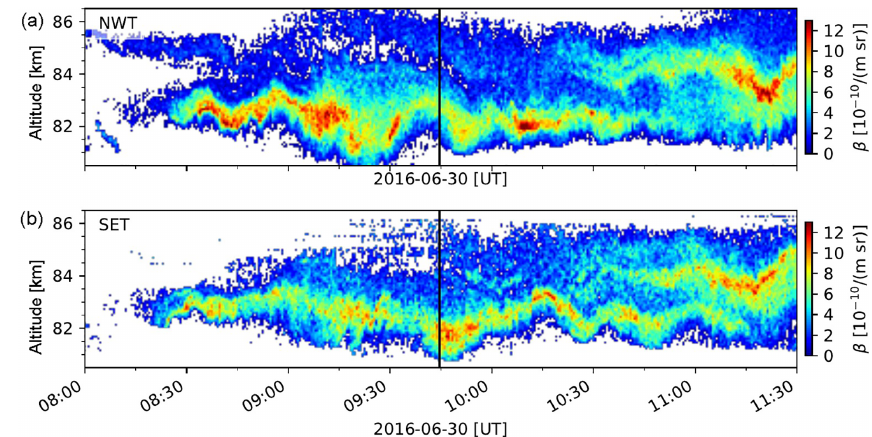
Figure 5. Backscatter coefficient (532nm) measured by the RMR lidar along the payload trajectory of MXD-1 (a) and about 18km to the southeast of the trajectory (b) . The time of the rocket penetrating through the NLC layer is marked by the vertical black line.